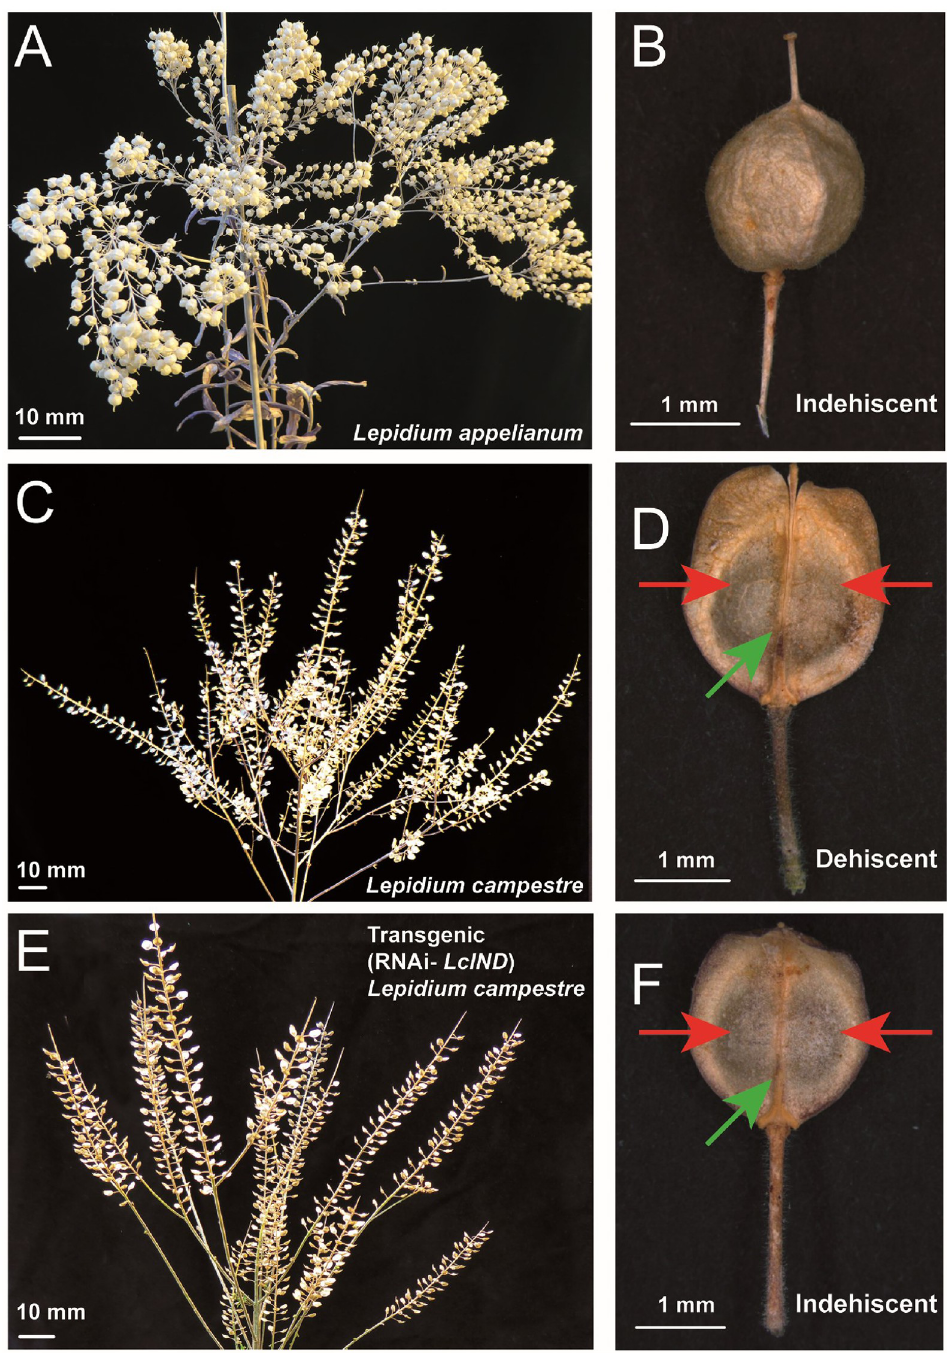
Fig 1. Morphology of mature infructescences and fruits of Lepidium appelianum , L . campestre , and RNAi- LcIND L . campestre . (A, B) Mature indehiscent fruits of L . appelianum contain 1–2 seeds enclosed within a bulbous papery pericarp. (C, D) Mature fruits of L . campestre dehisce upon maturity to release two seeds enclosed within the pericarp by detaching of the two fruit valves (red arrow) from the replum (green arrow). (E, F) Transgenic modification of LcIND in L . campestre produced indehiscent fruits containing two seeds enclosed within un-detached fruit valves from replum.